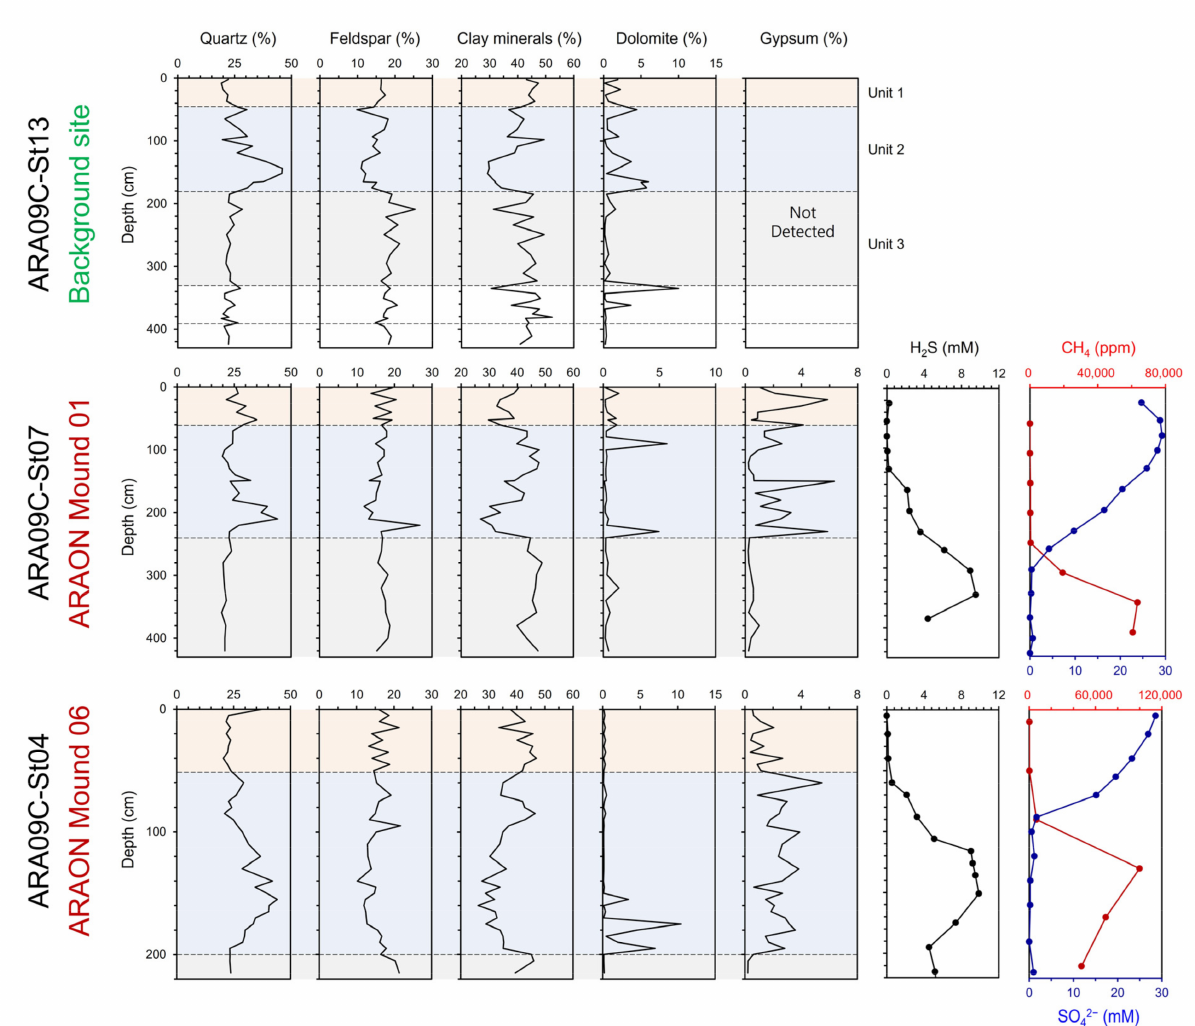
Figure 3. Down-core variations in major mineral and H 2 S data in sediment cores. CH 4 and SO 42 − data from Kim et al. [5]. The dotted lines represent the boundaries of the separated